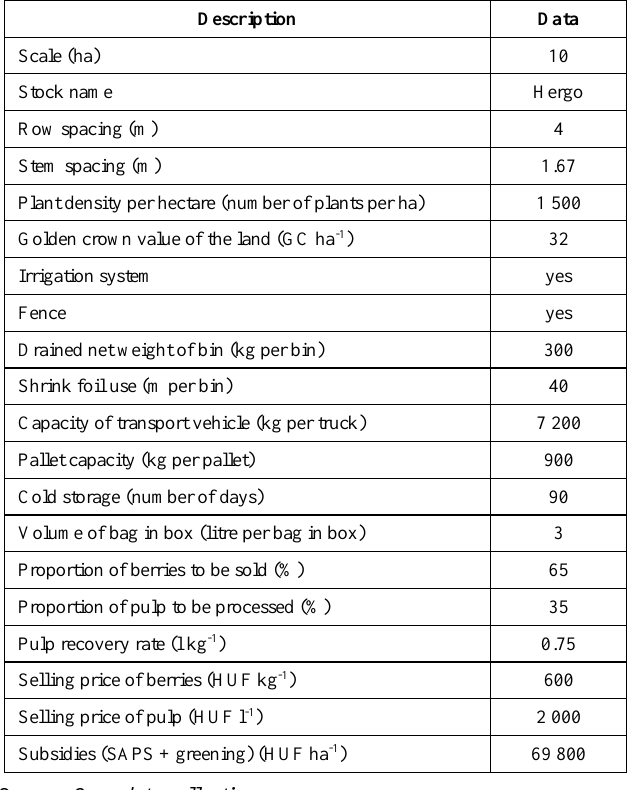
Table 1. Boundary conditions of the model